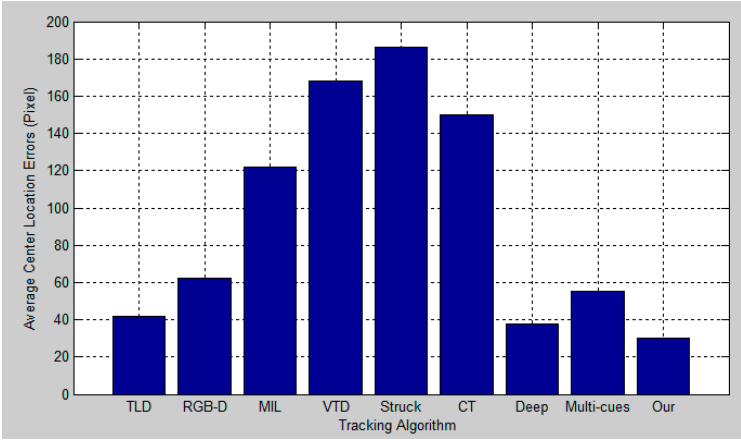
Figure 15. Quantitative evaluation in terms of average center location error (in pixel) for the fourth experiment.